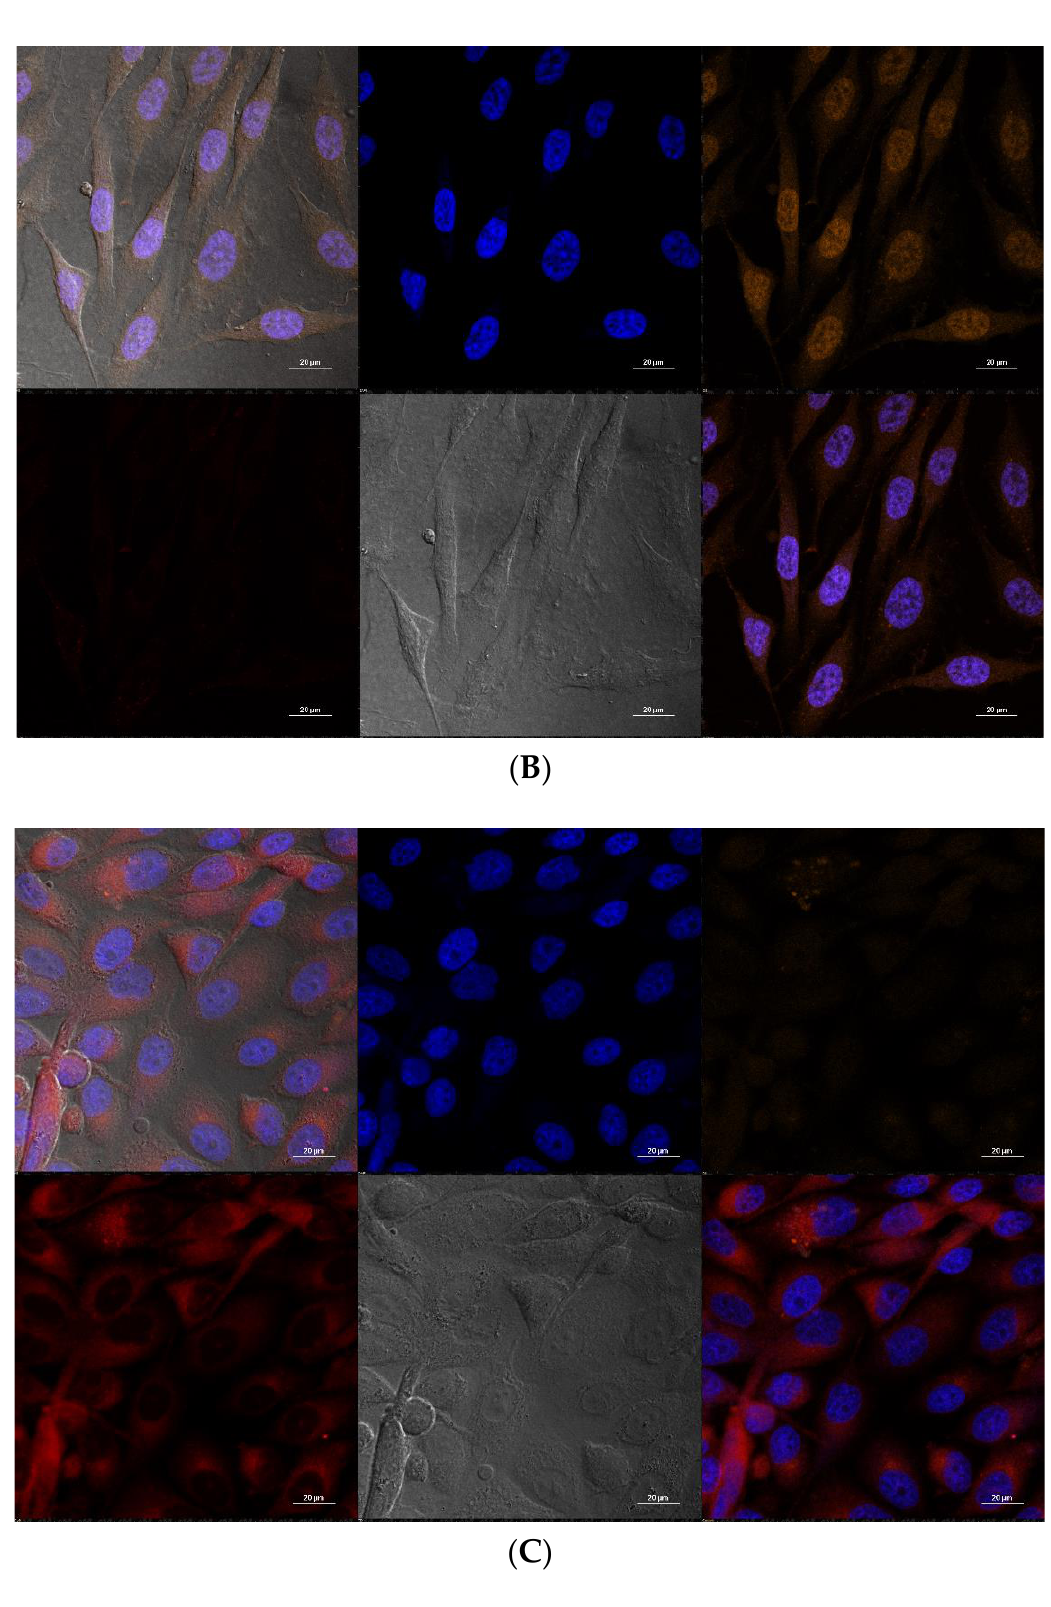
Figure 5. Changes in fluorescence intensity of Cy3 and Cy5 dyes attached to MNP in cells ( A ) and representative images of cells incubated with Cy3 – Cy5-labeled NPs at the first time point at 1 h ( B ) and last time point at 72 h ( C ). The bar graph contains the mean value ± SD.